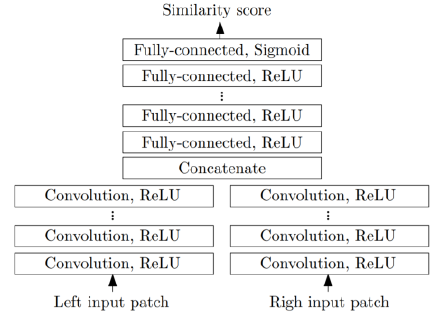
Figure 2. The accurate architecture of the MC-CNN. (Zbontar & Lecun, 2015, 2016)